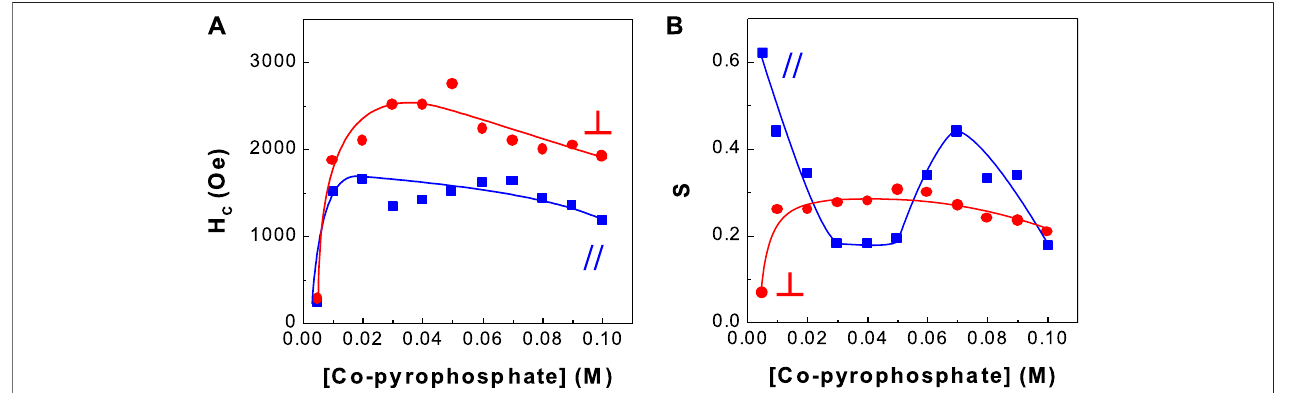
FIGURE 2 | Dependence of coercivity and squareness of CoPt thin fi lms on Co-pyrophosphate concentration (A) coercivity and (B) squareness.